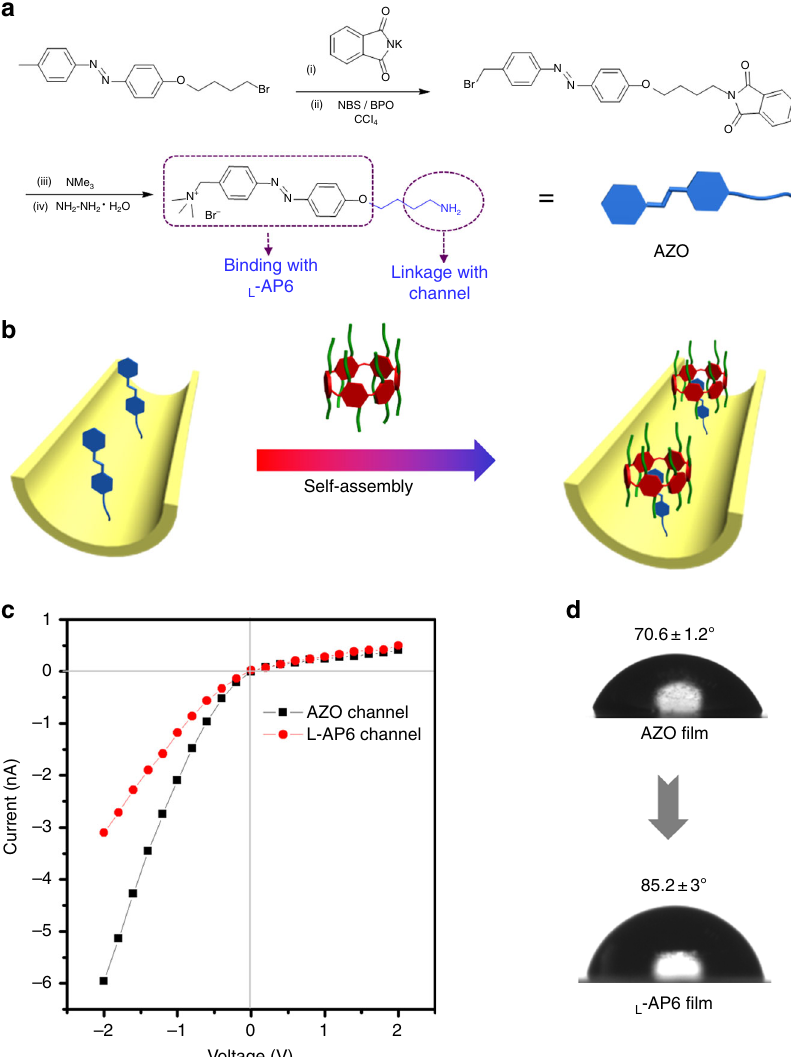
Fig. 3 Fabrication of the chiral nanochannel. a Design and synthesis of the AZO linkage unit; b the construction process of the chiral nanochannel by host – guest systems; c current/voltage ( I / V ) curve change in the single nanochannel after each modi fi cation; d contact angle change on the PET fi lms after each modi fi